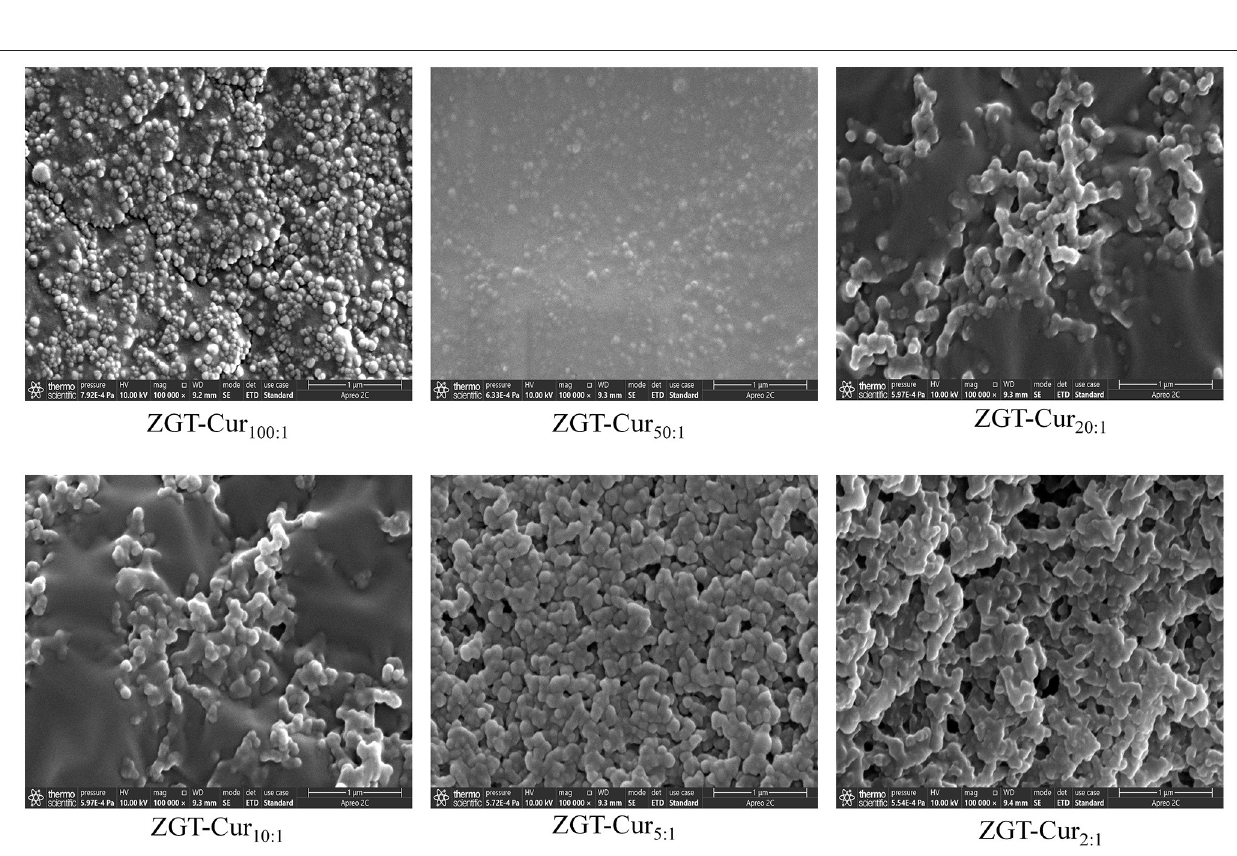
Frontiers in Nutrition |